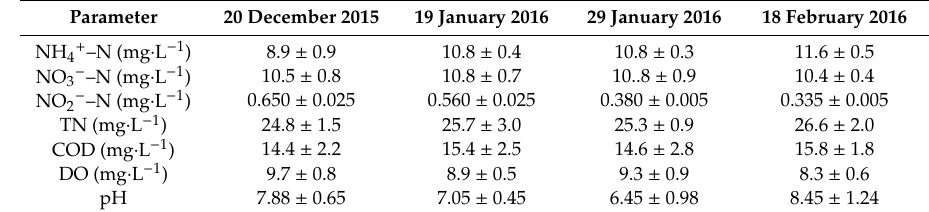
Table 1. Characteristics of the influent at the beginning of 2nd, 4th, 6th, and 8th batch (means ± S.D., p < 0.05, n =